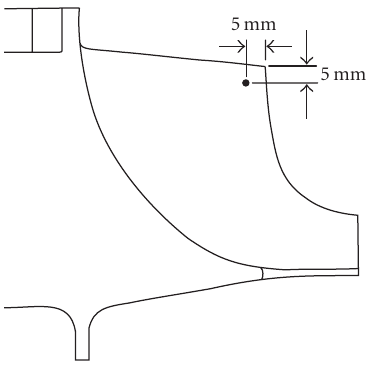
Figure 14: Excitation point by a mini impact hammer.